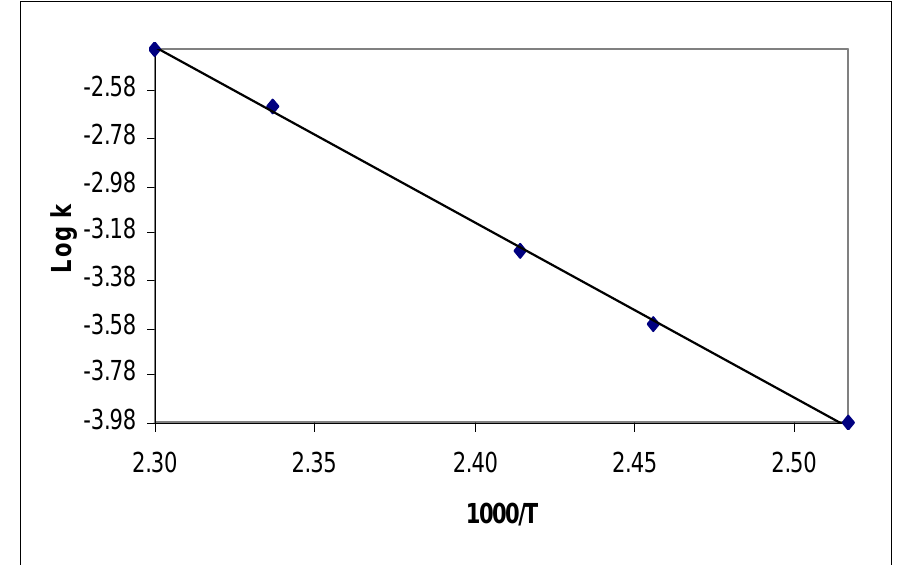
Figure 2. Arrhenius plot for pyrolysis of compounds 5b